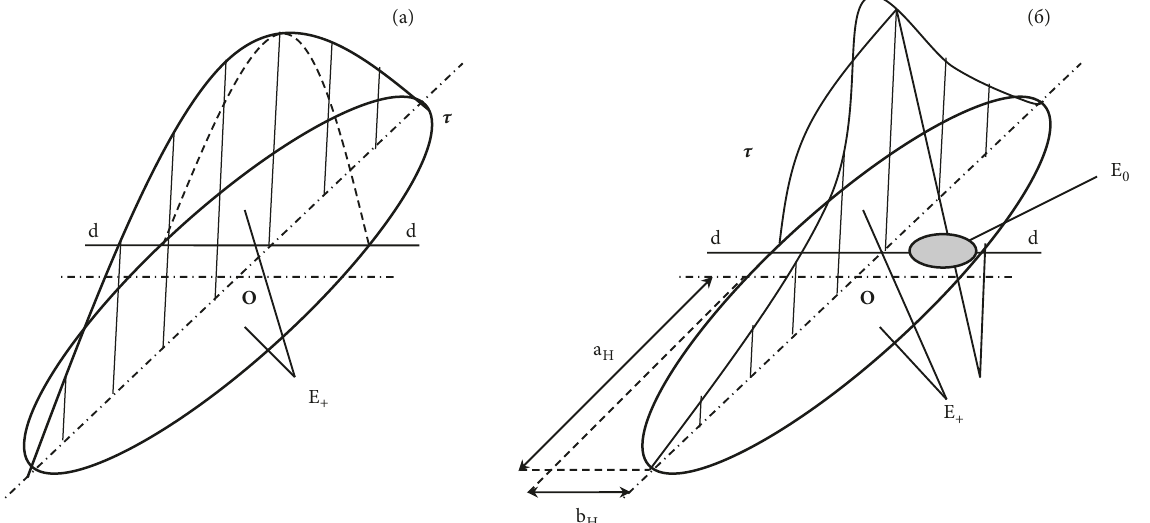
Figure 5: The distribution of tangential stresses over the contact surface in the Novikov transmission: (a) - X 1 = X 2 = 0: complete slip; (b) -X 1 = -0.3; X 2 = + 0.3: slippage and grip. X 1 and X 2 : the coefficients of displacement, respectively, gears, and wheels.